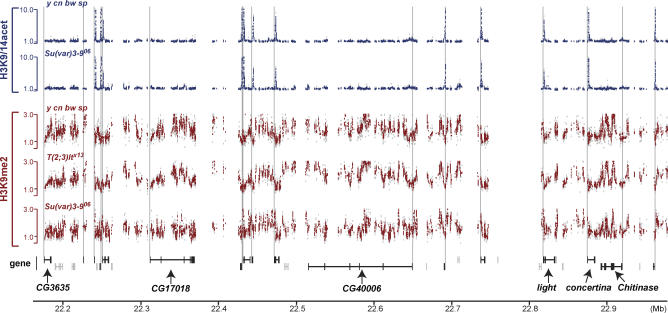
Modified Histone Profiles of the 2Lh Genes Revealed by ChIP-chip AssaysComparison of H3K9/14acet (top) and H3K9me2 (below) profiles for the genotypes indicated at the top of each line shows the reproducibility of the profiles. ChIP-enrichment relative to total genomic DNA control is plotted. The raw data are shown as gray dots, and averages of five adjacent probes are shown as colored dots (blue for H3K9/14acet and brown for H3K9me2). The annotated heterochromatic genes are shown below with the depiction of exon/intron structures. Genes on the plus and minus strands are shown in the top and the bottom tiers, respectively. Black genes have cDNA evidence to support their existence and the positions of their annotated 5′ ends are marked by the gray vertical lines. Gray genes are based solely on computational predictions. x-Axis shows the R5.1 genome coordinates.